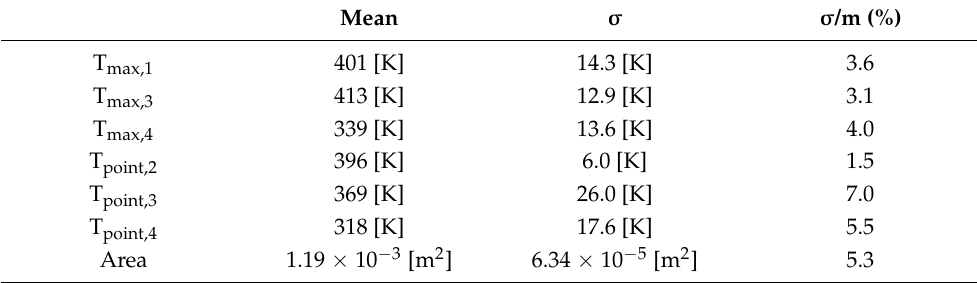
Figure 18. Pdf of maximum temperature with normal input distribution of vf.